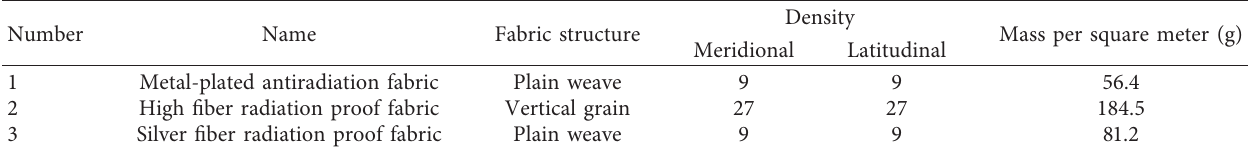
Figure 10: Boundary conditions of the magnetic medium interface. Table 4: Specifications of electromagnetic shielding materials.